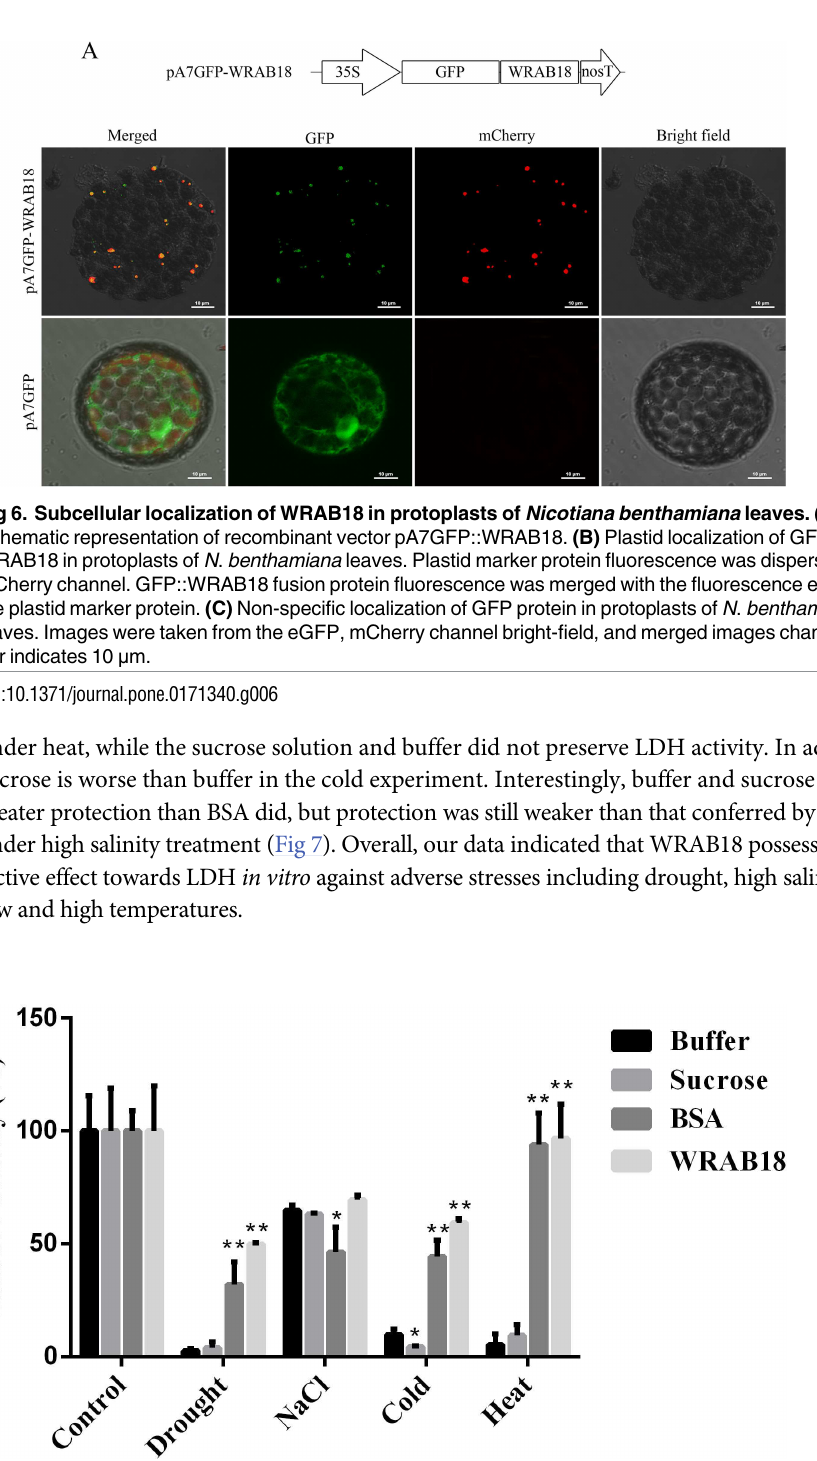
Fig 7. Protective function of WRAB18 on LDH activity under severeconditions. LDH solutionwas culturedwith BSA, sucrose solution,and PBS buffer, and purifiedWRAB18 was dehydrated to 70%, rehydrated to the originalvolume, supplemented with 200 mM NaCl for 2 h, placed on ice for 12 h, and left at 45˚ C for 30 min. Reactionswere repeatedthree times. Statistically significantdifferenceswere analyzed using Student’s t-test ( * p < 0.05or ** p <